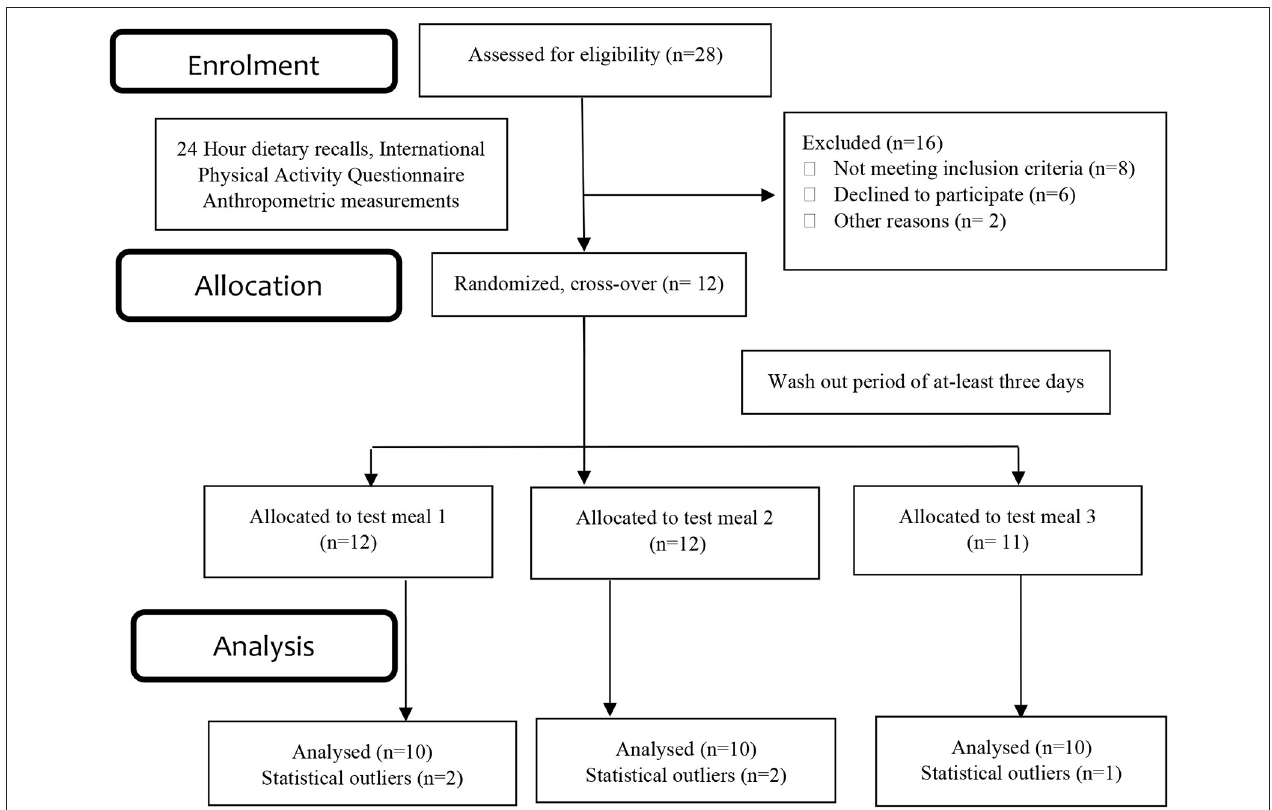
FIGURE 1 | Consolidated standards of reporting trials (CONSORT) flow chart– trial